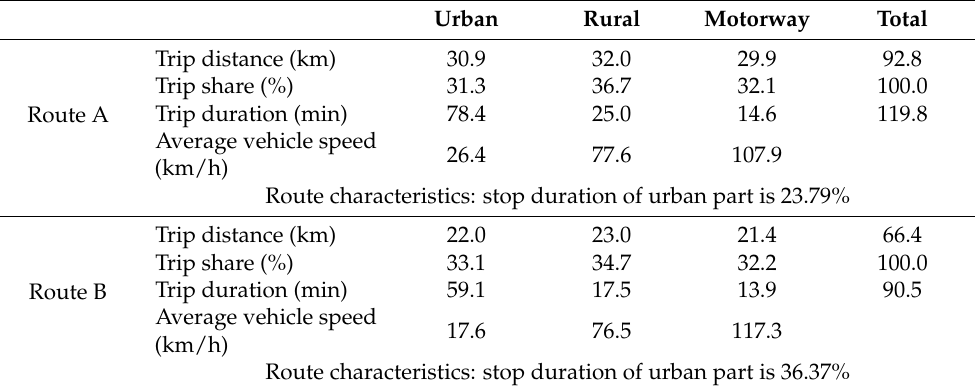
Table 5. Summaries of RDE test routes.